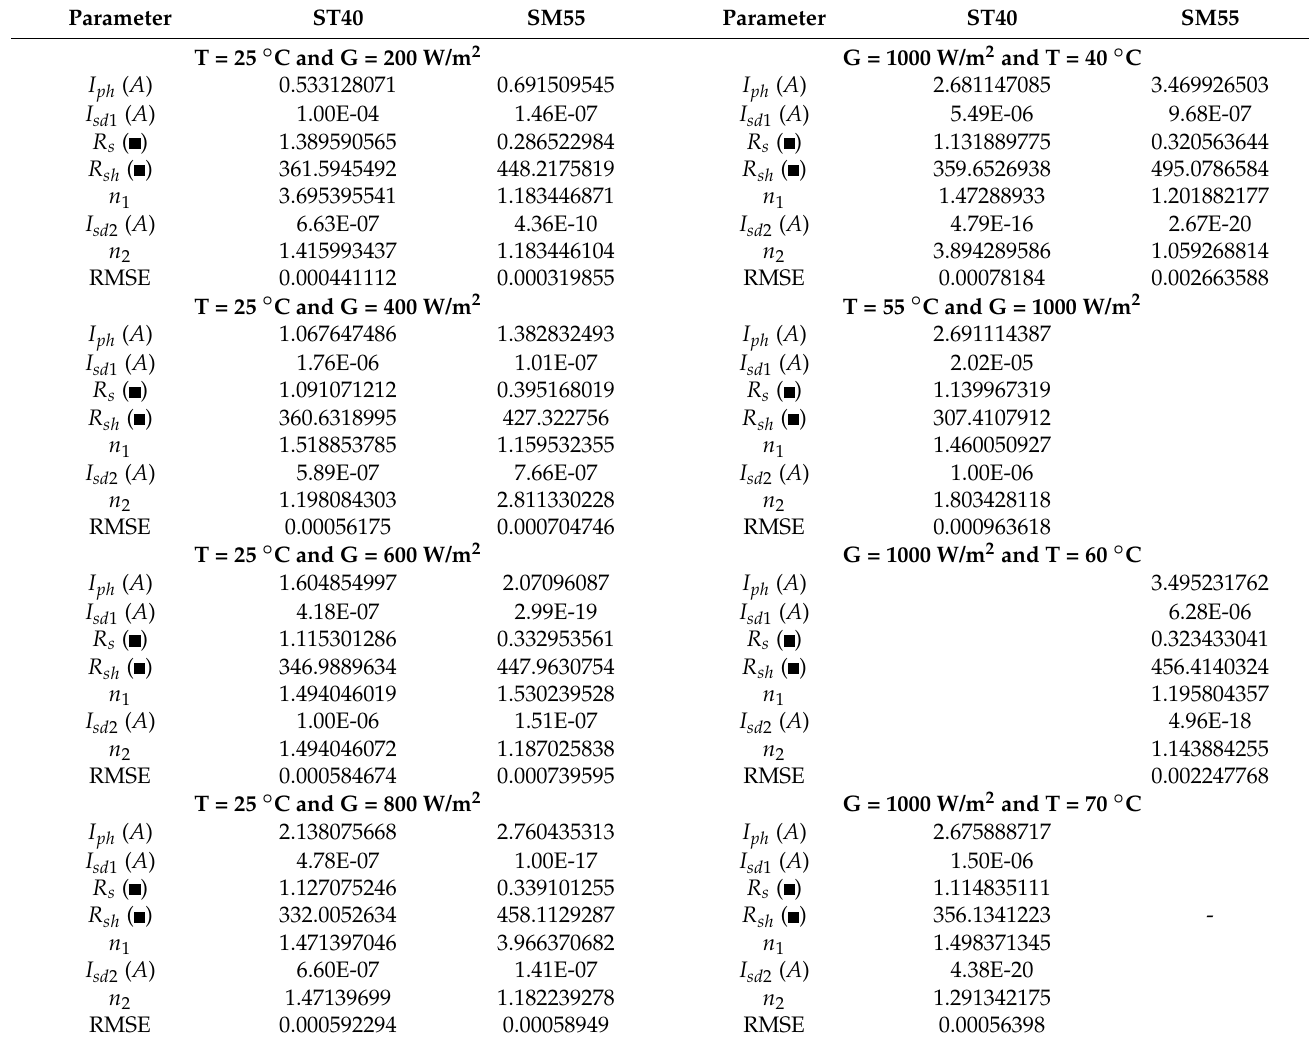
Table 19. The estimated parameters by MJSO at various G and T levels based on